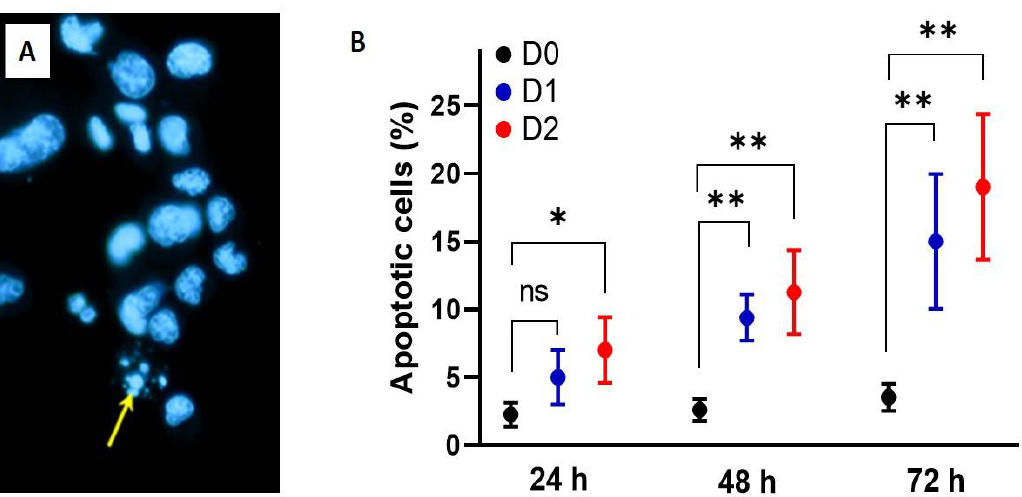
Figure 4. Time course and dose-response e ff ects of Allium subhirsutum methanolic extract at di ff erent doses: 0, 50 and 100 µ g / mL (D0, D1 and D2, respectively), on Walker 256 / B cell apoptosis. The cells were incubated for 24, 48 and 72 h. Cell apoptosis was assessed using the Hoechst 33,342 assay ( A ). Note that D1 and D2 of AS extract were found to induce statistically high significant (* p < 0.001) increases after 48 h and the e ff ect was more prominent at 72 h ( B ). Values represent mean ± SD of n = 3. Groups